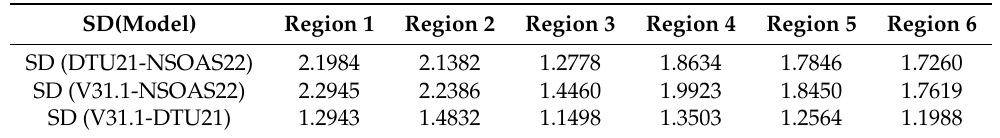
Table 9. Statistics of difference between NSOAS22, DTU21 and SS V31.1 (unit: mGal): Region 1, North Pacific; Region 2, South Pacific; Region 3, Mid-Pacific; Region 4, Indian Ocean; Region 5, North Atlantic; Region 6, South Atlantic.